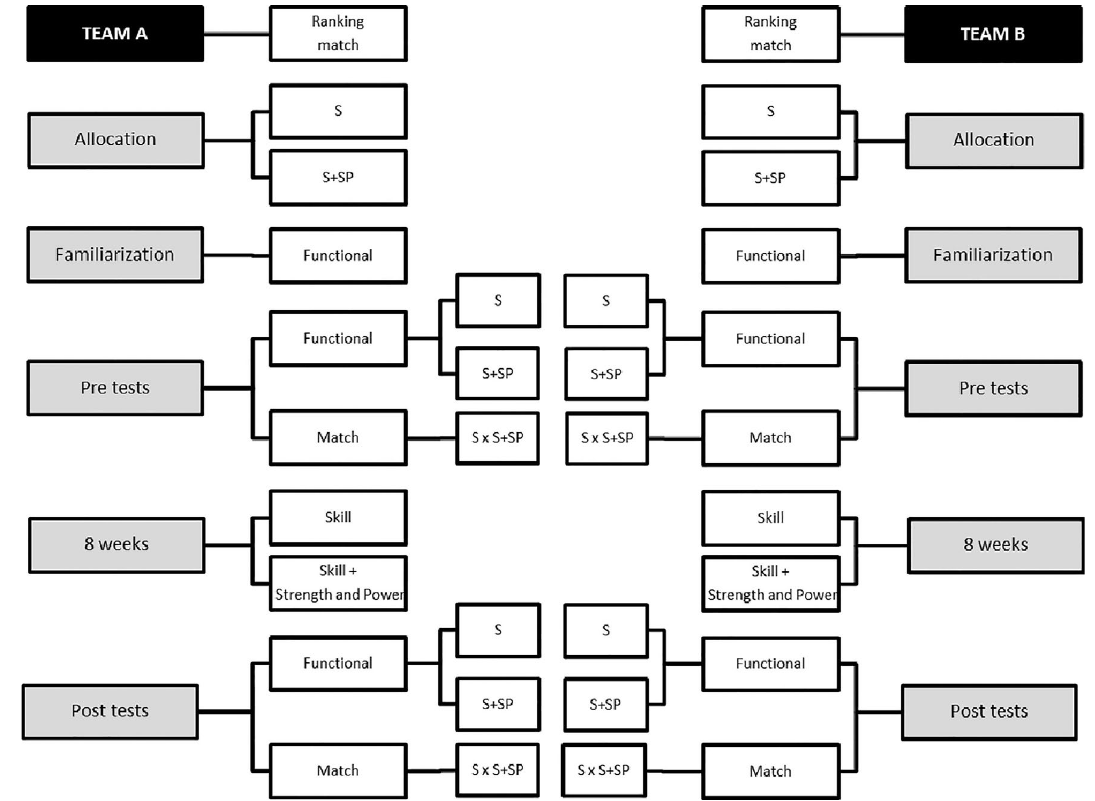
Figure 1 - Experimental design followed by both A and B